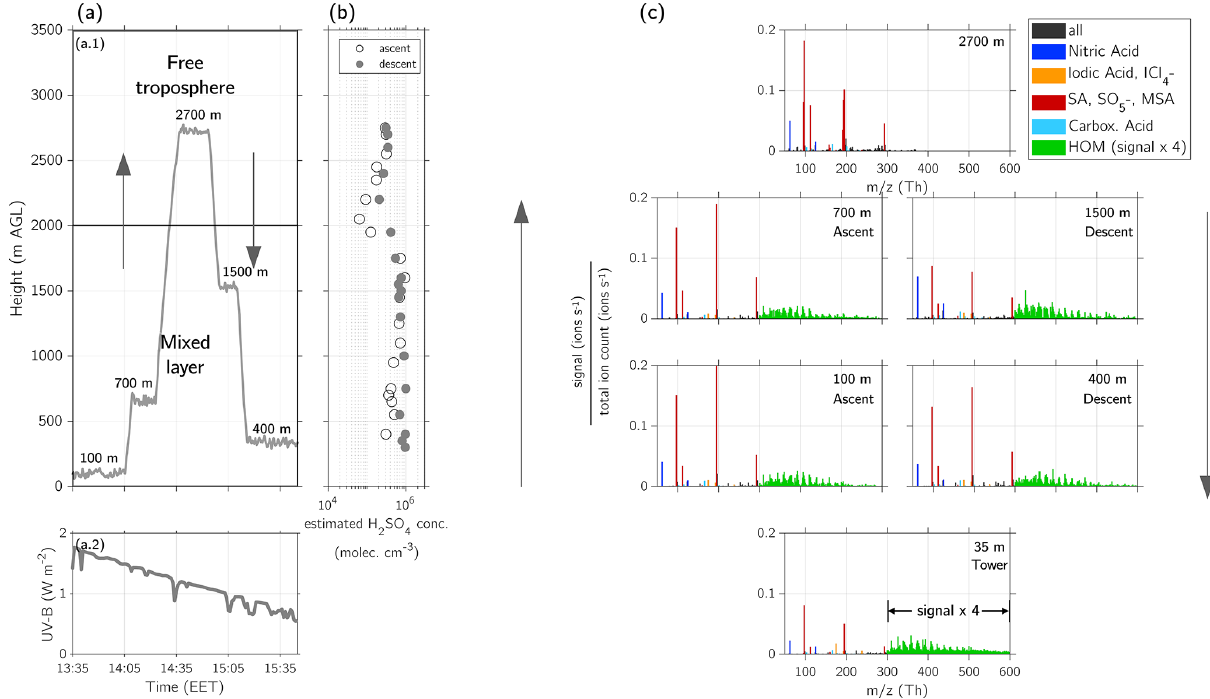
Figure 7. Vertical profile of ions above Hyytiälä on 2 May 2017 at 13:30–15:30EET. (a.1) Height profile of the flight measurements and indication of the different layers (mixing layer (ML) and free troposphere (FT)). (a.2) UV-B radiation measured on the ground at SMEAR II station during the flight. (b) Estimated sulfuric acid concentration in molecules cm − 3 during ascent (13:15–14:40EET) and descent (14:40– 15:30EET), calculated based on Beck et al. (2022). (c) Mass spectra measured with APi-TOF at different heights. The altitudes at which the mass spectra were measured are indicated in the figures and can be compared with the height profile of panel (a) . The lowest mass spectrum shows the measurements from the tower at SMEAR II station at 35m height. The presented data are an average from 14:00–16:00EET. The signal of the HOM-dominated ions (green) between 300–600Th is multiplied by a factor of 4 to make the pattern more visible. A peak list of the ML and the FT can be found in Table A1. The legend shows the colouring for compounds containing nitric acid (blue), iodic acid and iodine–chlorine (yellow), sulfuric acid (SA), SO − and methanesulfonic acid (MSA) (red), carboxylic acids (cyan), and HOM-dominated 5 ions